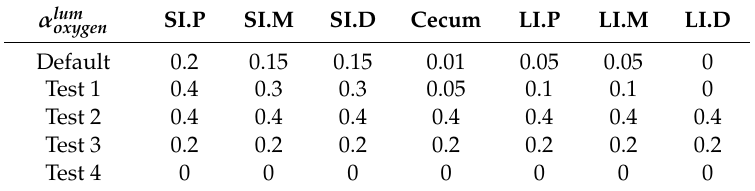
Table 4. Sets of values tested for the fraction of oxygen available to the luminal microbiota α lum oxygen .